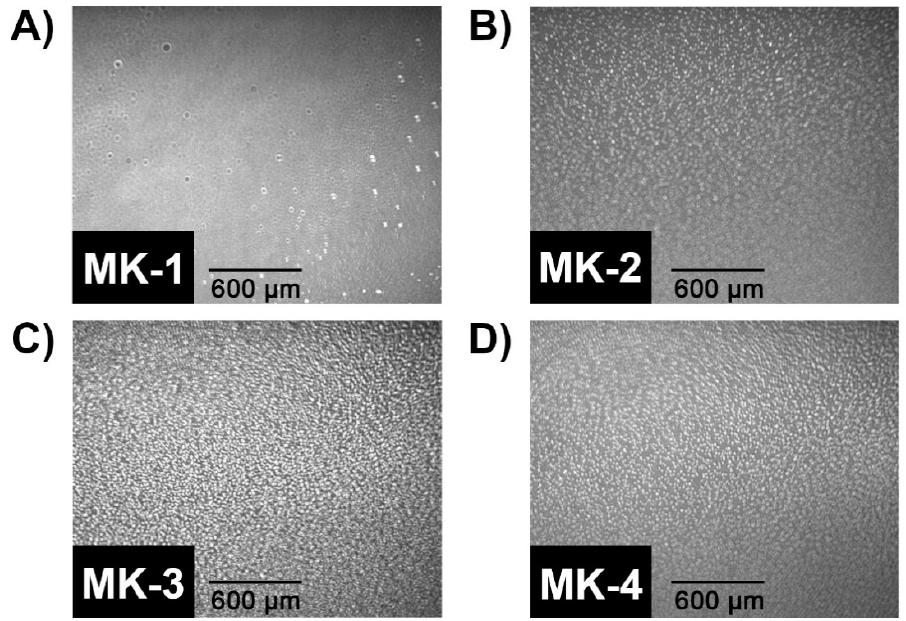
Figure 3. BAM images of pure MK films that demonstrated droplet-like structures were formed between 7.5 and 13 mN/m of surface pressure during compression. Images are shown at the approximate collapse pressure of each MK homologue. Images of ( A ) MK-1 (800 nmol), ( B ) MK-2 (120 nmol), ( C ) MK-3 (80 nmol), and ( D ) MK-4 (80 nmol) were captured at 12.5 mN/m, 10.0 mN/m, 11.8 mN/m, and 10.7 mN/m, respectively. Each panel is 2387 × 1925 µ m. Images in this figure were cropped from raw images (640 × 480 px) to a final size of 382 × 308 px. All images were cropped from the upper right corner for consistency. Cropped images were then scaled up to 720 × 582 px. All image manipulation was performed in GIMP 2.10.22.